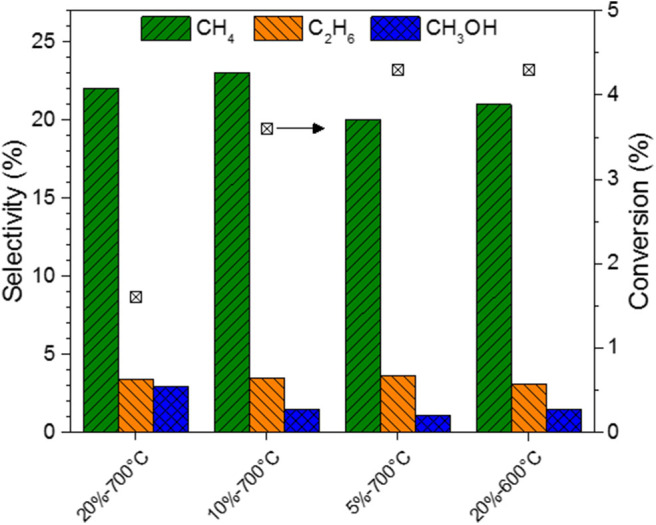
Selectivity to methane, ethane, and methanol, and conversion for MoC/TiO2-P as a function of the carburizing ethane concentration (5, 10, or 20% in H2), and the carburization temperature (600 or 700°C). Catalytic conditions: 400 mg of catalyst, 50 ml/min, 250°C, 30 bar, H2:CO2 = 3:1, 150 min on stream after stabilization of the temperature.